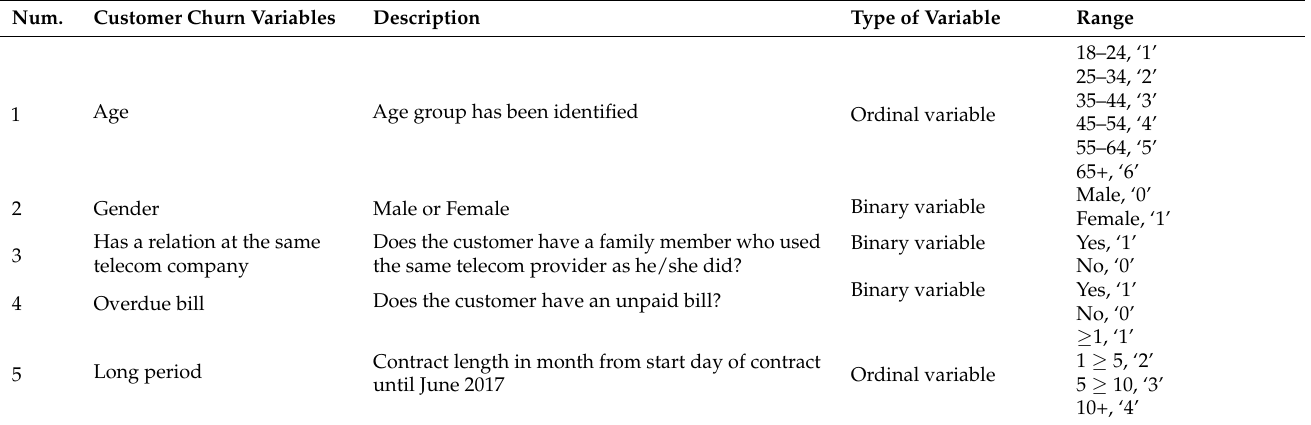
Table 2. Details of the customer churn